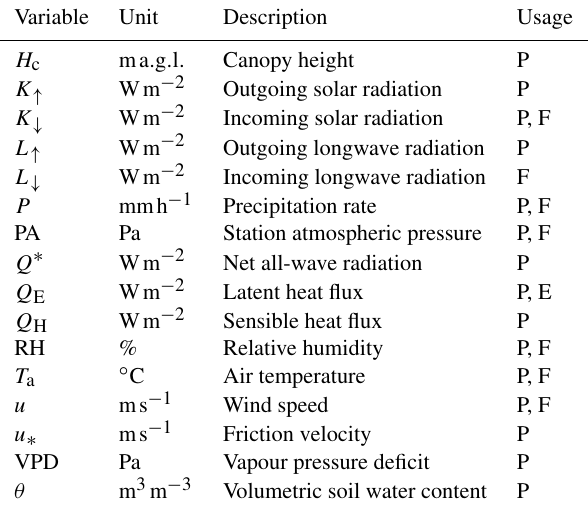
Table 2. FLUXNET2015 (Pastorello et al., 2020) variables used in this work to derive parameters (P), to force (F) model simulations and to evaluate (E)